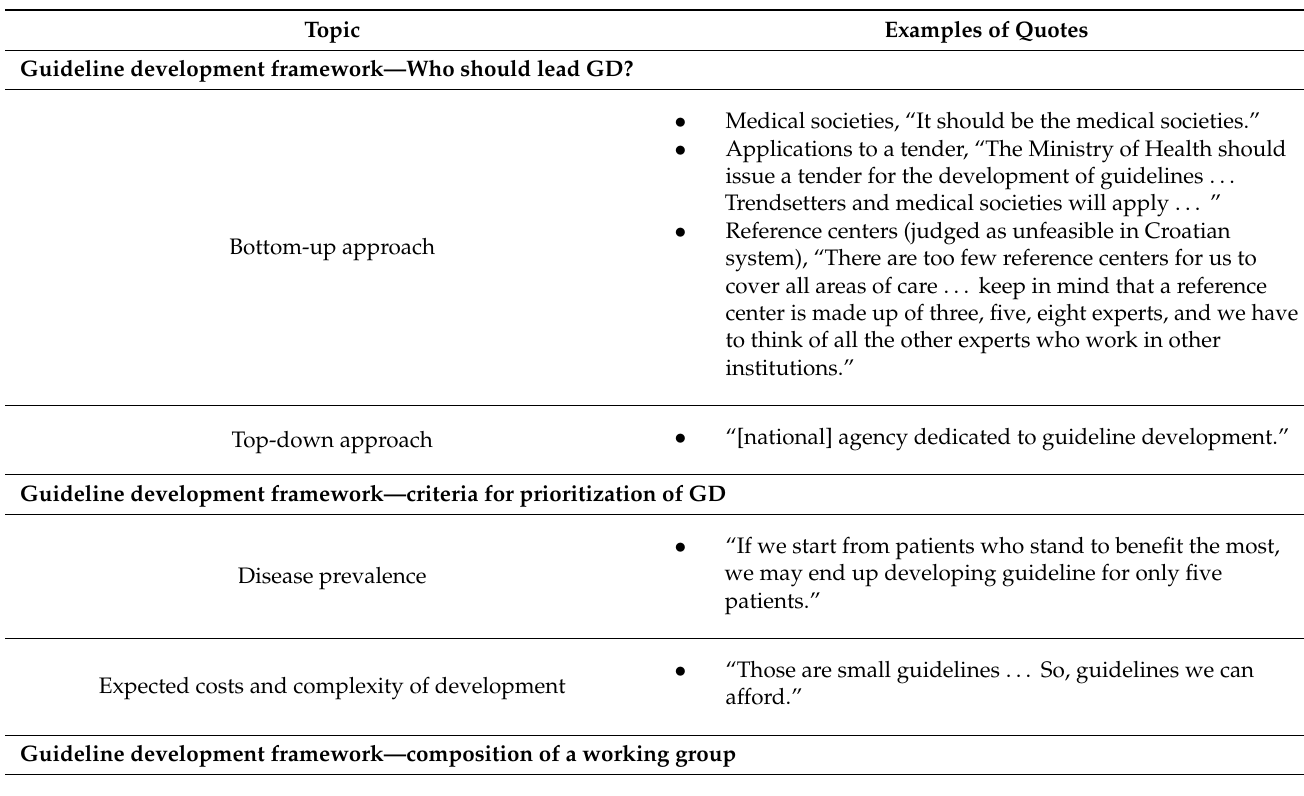
Table 2. Findings of the focus group discussions, organized by topic, with representative quotes by